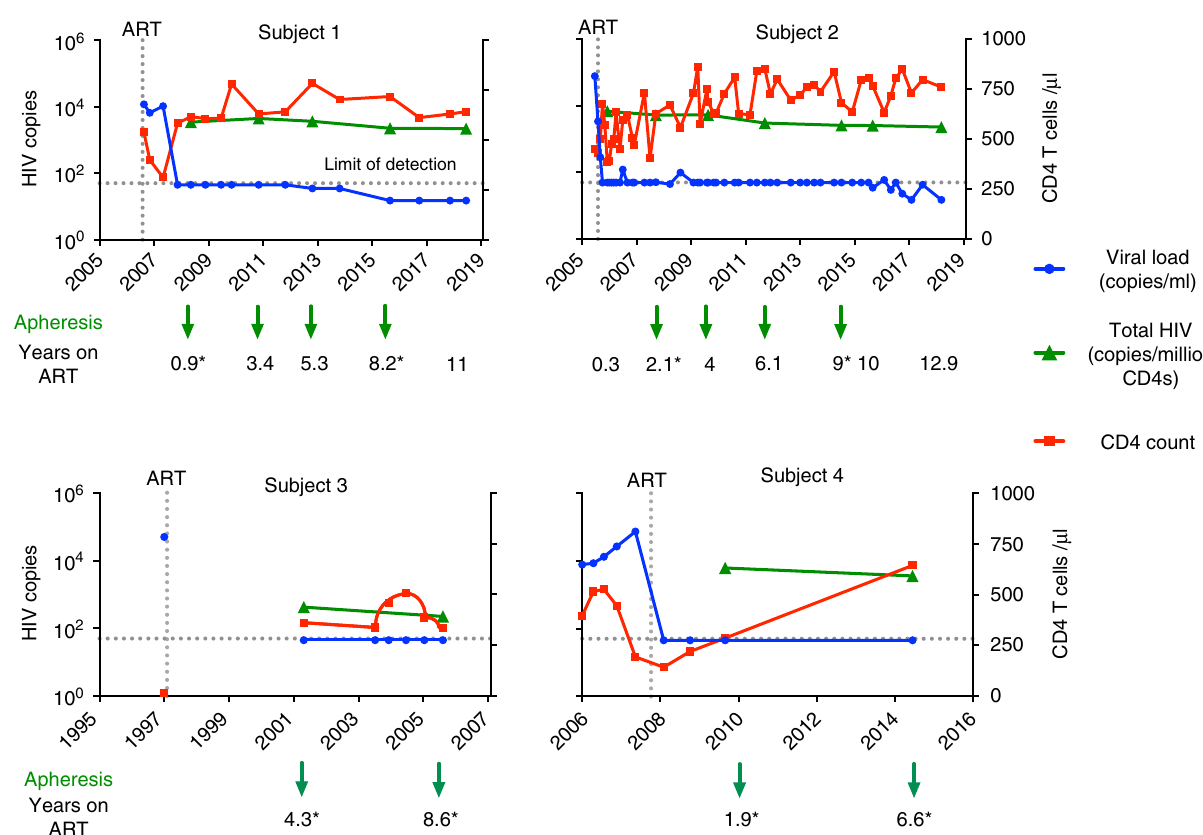
Fig. 1 Longitudinal parameters of four subjects over time on ART. Longitudinal levels of plasma HIV-1 RNA (blue), total HIV DNA (green), and CD4 T cell counts (red). For each subject, peripheral blood mononuclear cells (PBMCs) were collected by apheresis at the time points indicated in the graph. The arrows identify the time points we used for sequencing of both intact and defective proviruses, while for the remaining time points only near-full-length proviruses were sequenced. Asteriks identify the time points used for the deletion maps in Fig. 4. Total HIV DNA was quanti fi ed by primers binding to the long terminal repeat region of HIV-1. Values are normalized to CD4 T cell count and presented as log copies of HIV per million CD4 T cells. HIV RNA